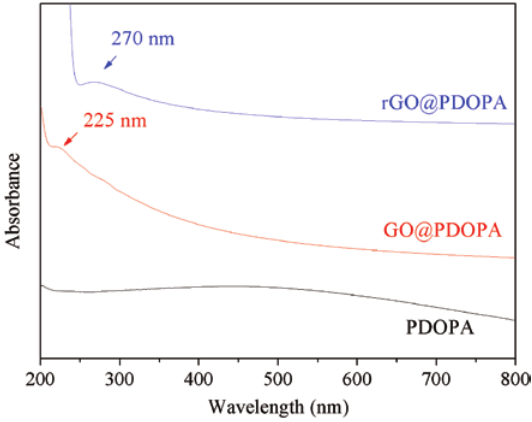
Figure 2: UV-vis spectra of PDOPA, GO@PDOPA and